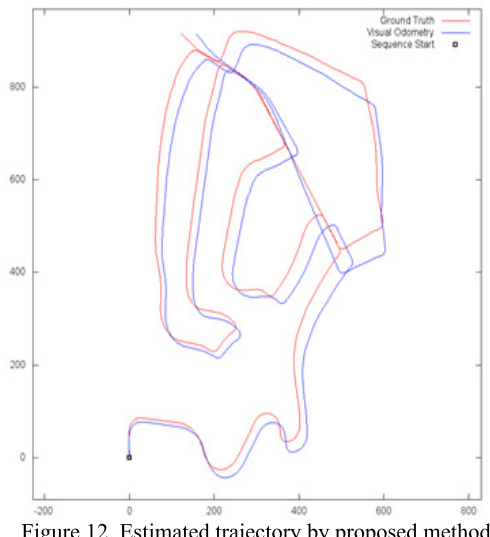
Figure 12. Estimated trajectory by proposed method Figure 12 shows the result of the proposed method in sequence 02. We used five images to verify the corresponding points and estimate the pose. As a result of the experiment in 9 sequences, an average rotation error was 0.005 degree per meter and the translation error rate was 6.8%. It took about 0.12 seconds processing time per frame.